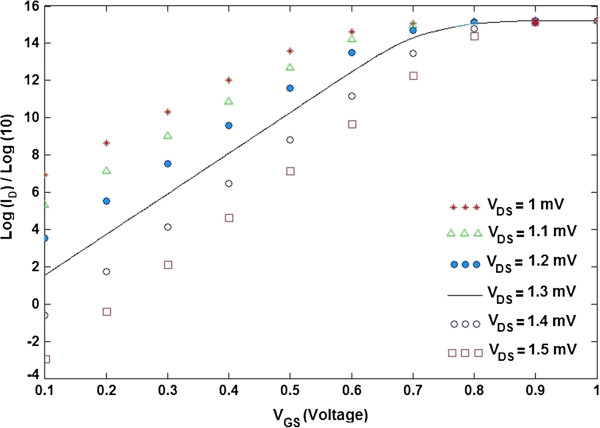
ID (μA)-VGS (V) characteristic of TGN SB FET at different values of VDS.